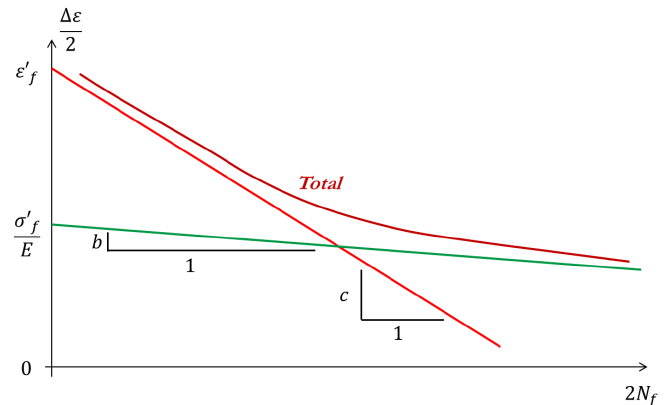
Figure 2. Elasto-plastic components fatigue behavior (Adapted from Balbo,